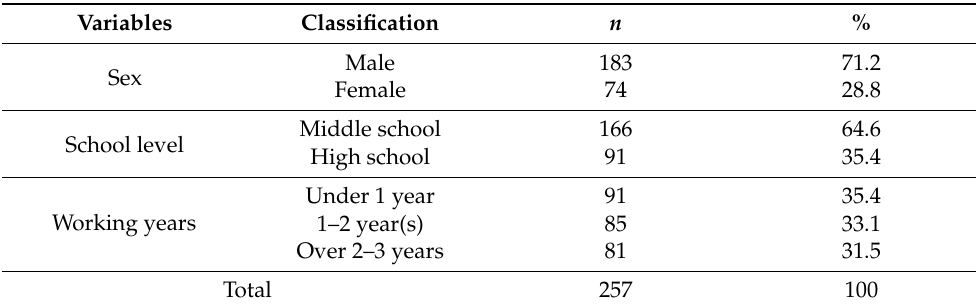
Table 1. Demographic characteristics of